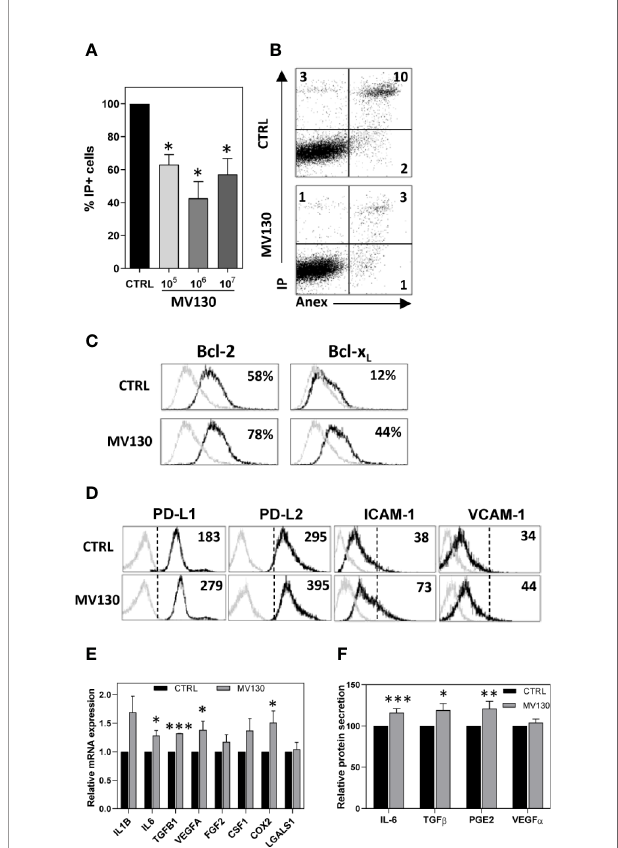
FIGURE 1 | Treatment with MV130 modi fi es biological properties of MSCs. MSCs were treated with MV130 for 2 h. (A, B) After 24 h, MSCs were stained with Annexin V and IP and cell viability was analysed by fl ow cytometry. Mean ± SEM of 5 independent experiments (A) and a representative experiment (B) are shown. (C) MSCs were treated with MV130 for 2 h. Bcl2 and Bcl-x L expression in MSCs were analyzed by fl ow cytometry 24 h after treatment. The percentages of positive cells are indicated in each histogram. Gray fi lled histograms represent isotype control staining. Data are representative of 4 independent experiments. (D) 48 h after treatment, the expression of different surface markers was studied on MSCs by fl ow cytometry. Representative histograms and MFI values are shown (n = 3-4). Gray histograms represent isotype controls. (E) mRNA expression for different immunomodulatory factors was studied on MSCs by qRT-PCR. Data represent mean ± SEM of 8 to 12 independent experiments relative to individual controls. (F) Supernatants from MSC cultures were collected 48 h after treatment. Protein secretion relative to individual controls is expressed as mean ± SEM from 15 independent experiments (*p < 0.05; **p < 0.01***p < 0.005 by Wilcoxon